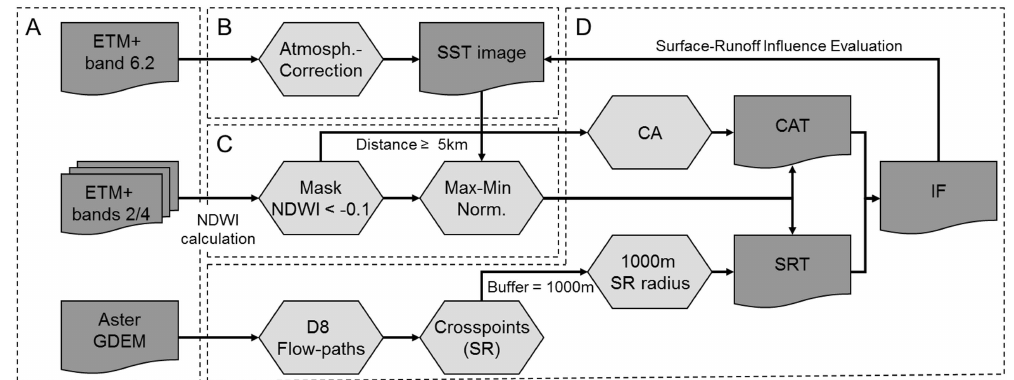
Figure 3. Flowchart of CAT and SRT derivation for surface-runoff influence evaluation; dotted-line boxes: (A) raw data; (B) pre-processing of thermal image; (C) pre-processing for IF calculation; (D) IF calculation.